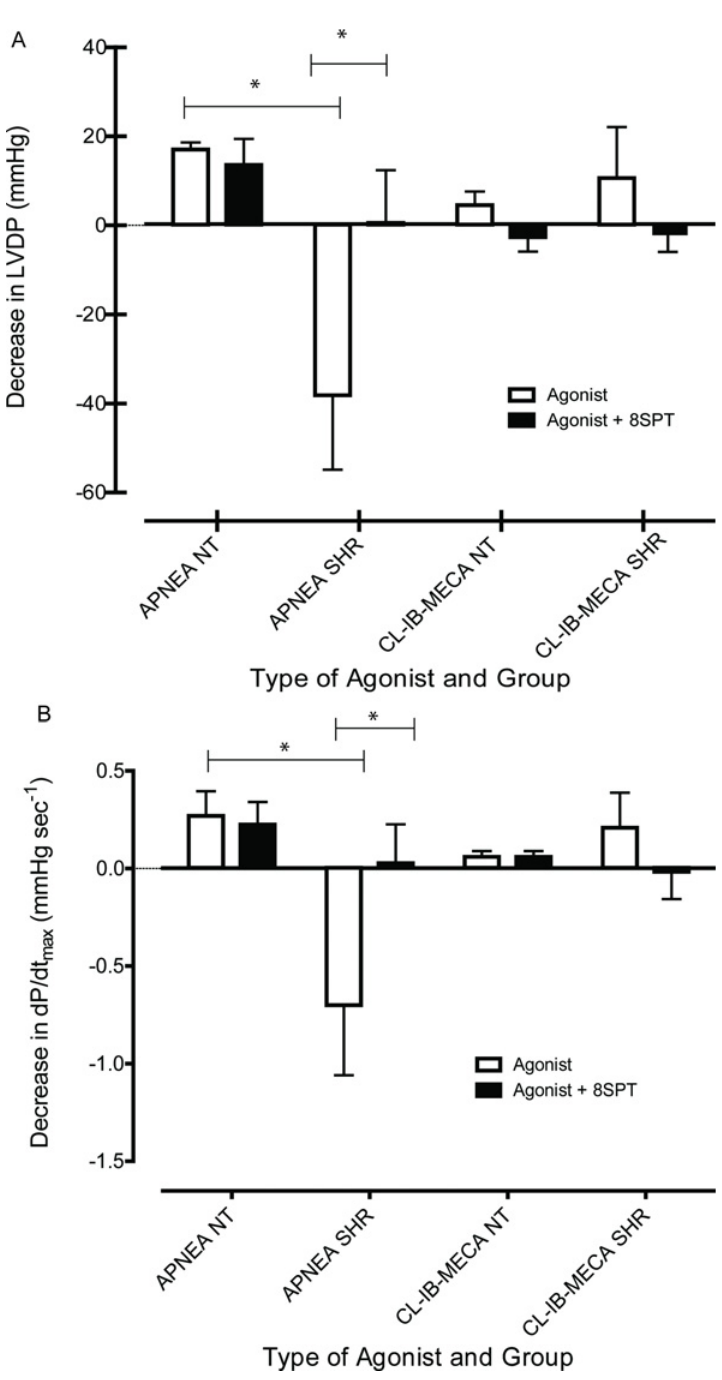
Fig 4. Mean decrease in (A) left ventricular developed pressure (LVDP) and (B) the left ventricle contractility (dP/dt) maximum at the concentration of 10 -5 M of APNEA or CL-IB-MECA for control normotensive rats (NT) and spontaneously hypertensive rats (SHR). Data obtained from each group was statistically analysed using one-way ANOVA followed by Tukey ’ s Multiple Comparison Test/Bonferroni correction. * A p value (cid:1) 0.05 was considered statistically